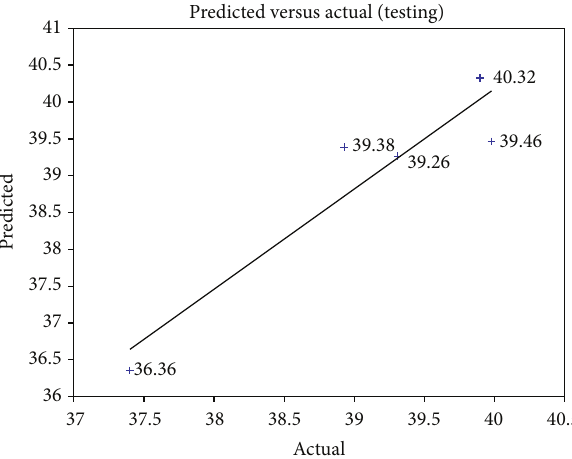
Figure 7: Comparison between residual values and predicted values during testing